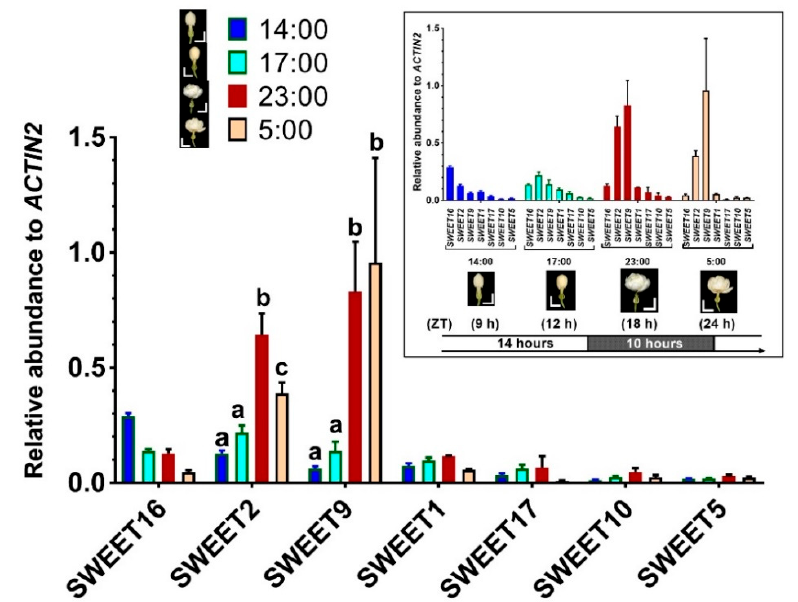
Figure 3. SWEET gene expressions during J. sambac flower opening. Transcript abundance relative to JsACTIN2 was determined using quantitative RT-PCR in flower samples collected at indicated time points representing four floral stages. Significant difference between samples is indicated by different letters above the bars, which was conducted using the two-way ANOVA and multiple T-test implemented in the Prism software (version 7.04). The insert rearranges the data by the sampling time points. To correlate the time points with the circadian light/dark rhythm, the corresponding Zeitgeber time (ZT) was given below the sampling stage. Data are mean ± SD ( n = 3 biological replicates). Scale bars = 1 cm.